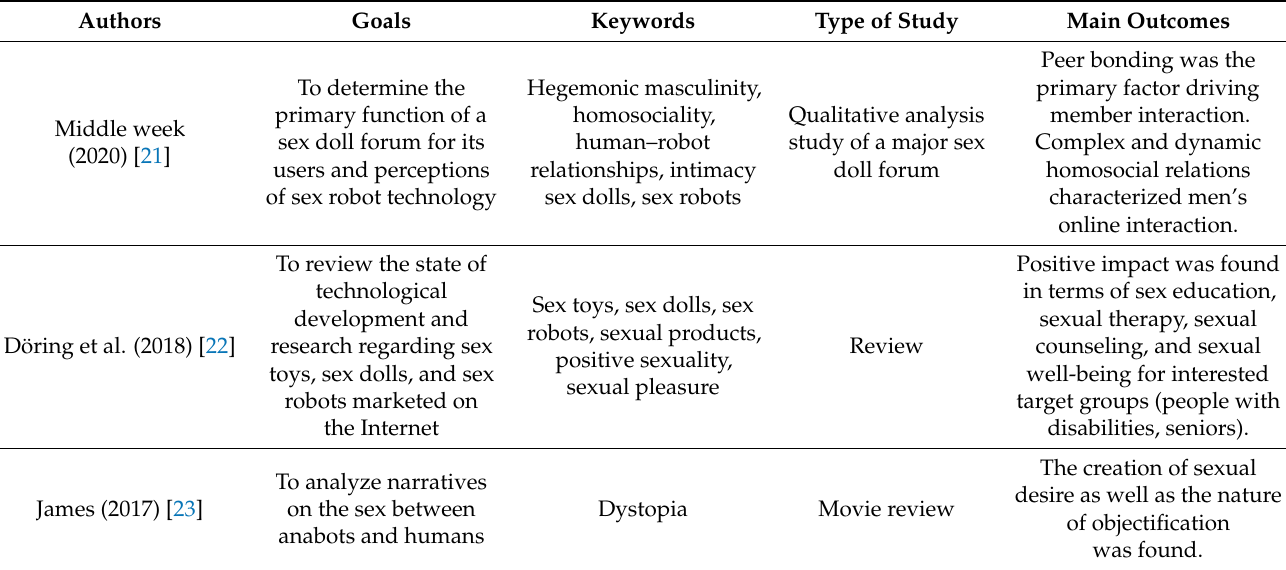
Table 2. Research question 2 (RQ2) about interactions, type of study, and